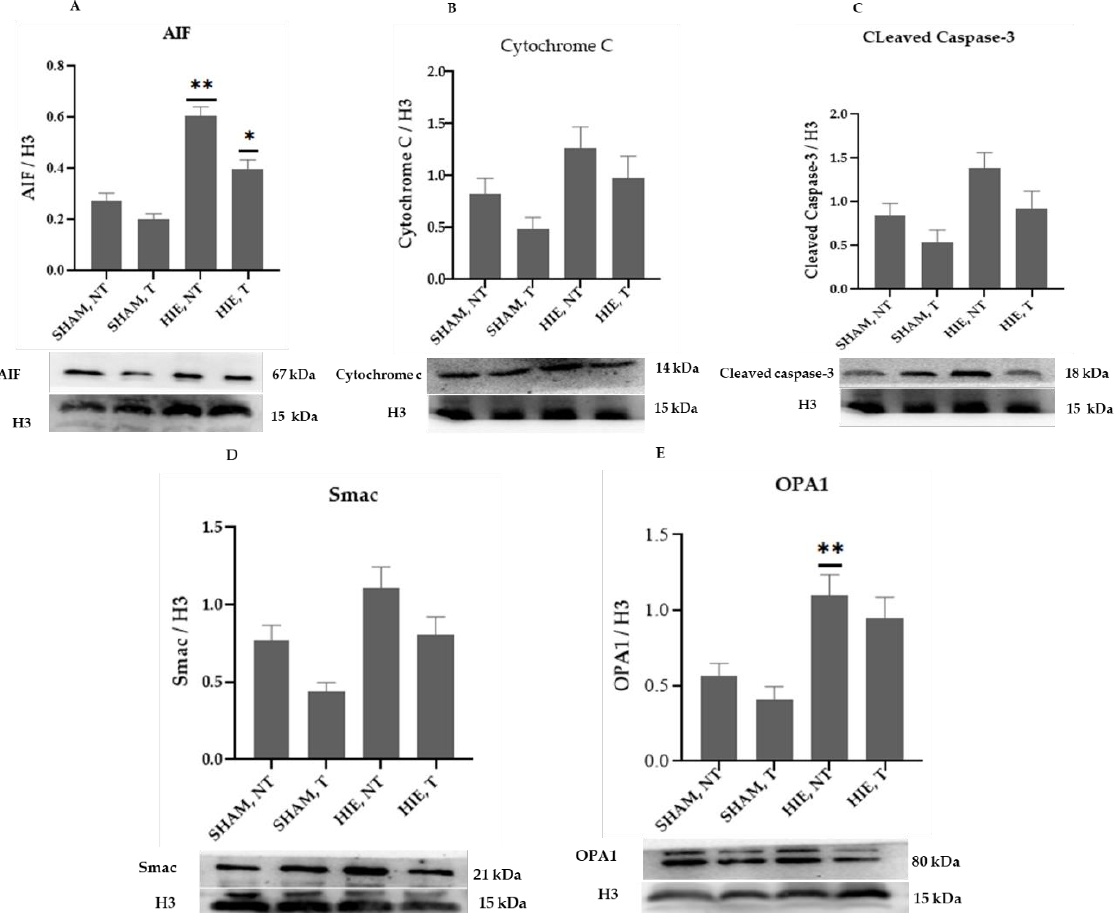
Figure 3. Protein changes in the nuclei of the hippocampus. Examples of Western blot bands normalized to histone 3 (H3) are presented (with the matching wells). Units are presented relative to H3 content. ( A ) AIF, apoptosis-inducing factor, ( B ) cytochrome c, ( C ) cleaved caspase-3, ( D ) Smac/Diablo, and ( E ) OPA1. Asterisks denote statistically significant differences between groups (*, vs. SHAM, NT). One asterisk (*) denotes p < 0.05, (**) denote p < 0.01 F values were; F = 32.870 (AIF), F = 3.510 (cytochrome c), F = 4.733 (cleaved caspase 3), F = 6.650 (Smac/Diablo) and F = 7.896 (OPA1). HIE, NT denotes animals with hypoxic ischemic encephalopathy that did not undergo exercise training; HIE, T denotes animals with hypoxic ischemic encephalopathy that were subjected to exercise training; SHAM, NT denotes normal animals that did not receive exercise training, and SHAM, T denotes normal animals that received exercise training.